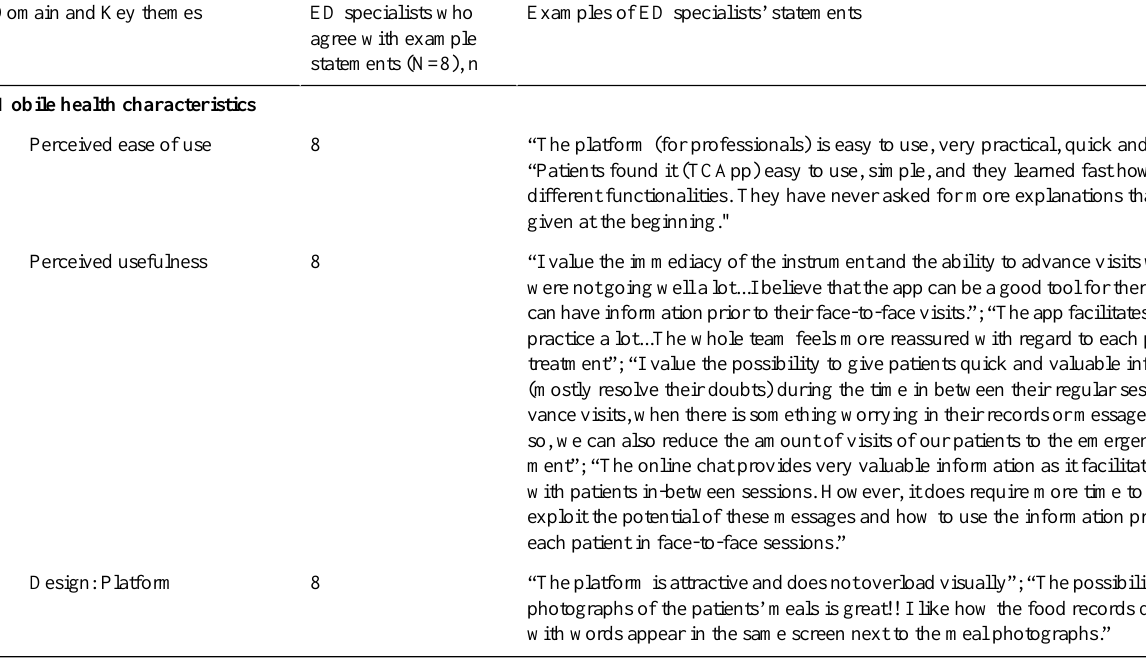
Table 7. Perceived advantages of the TCApp by eating disorder